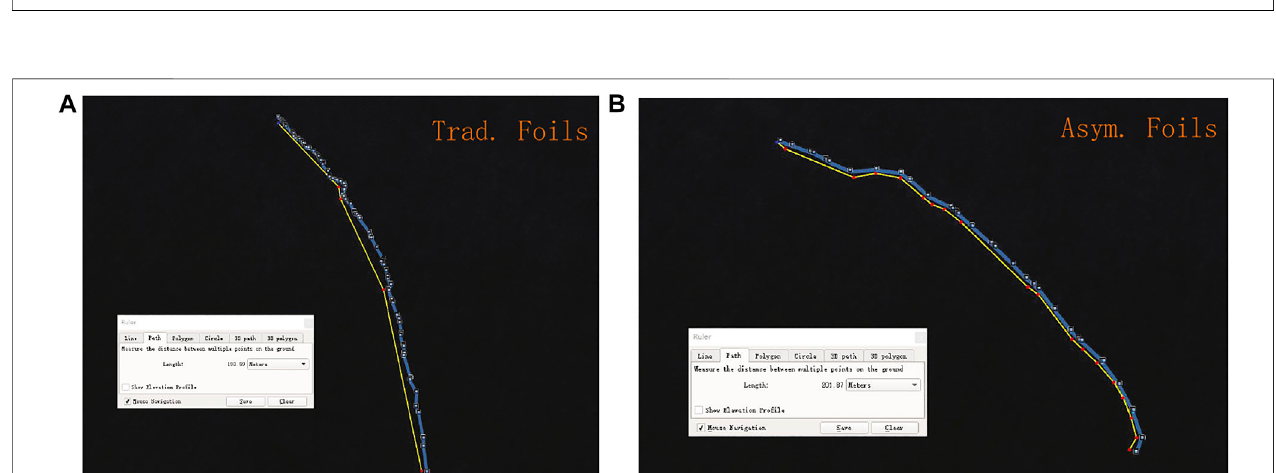
FIGURE 15 | (A) Sailing record of the wave glider with traditional foils: From 3:08:39 to 3:37:58; The sailing distance is 190.59 m. (B) Sailing record of the wave glider with asymmetric foils: From 3:08:38 to 3:37:09; The sailing distance is 201.87 m.